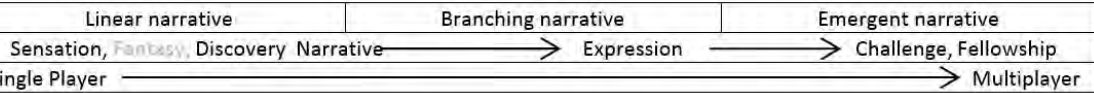
Figure 3. Mapping of game Aesthetics to site narrative